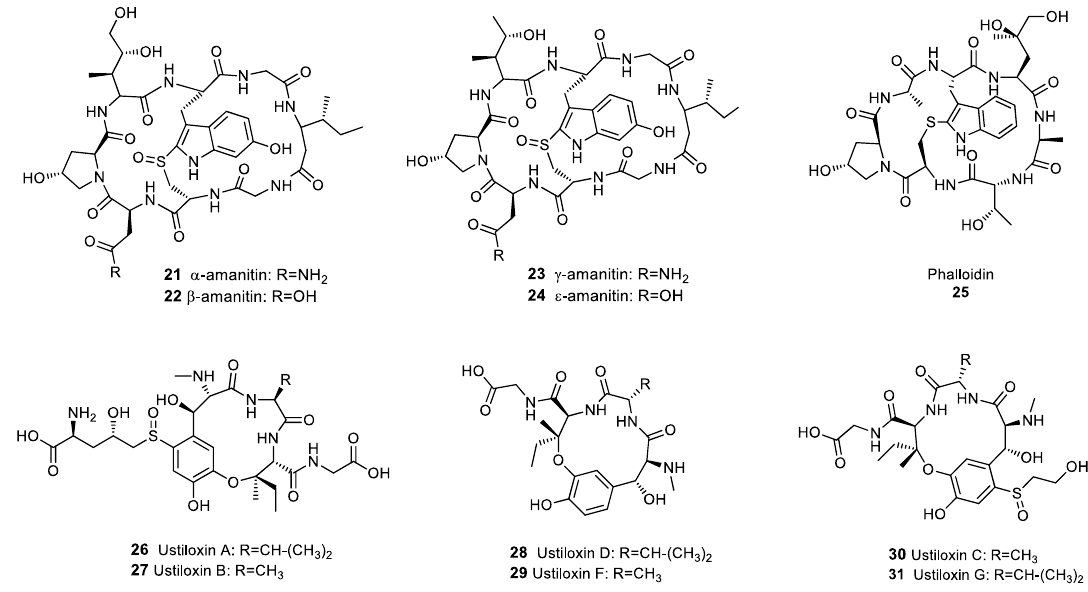
Figure 3. Structures of selected fungal ribosomally synthesised and post-translationally modified peptides (RiPPs).